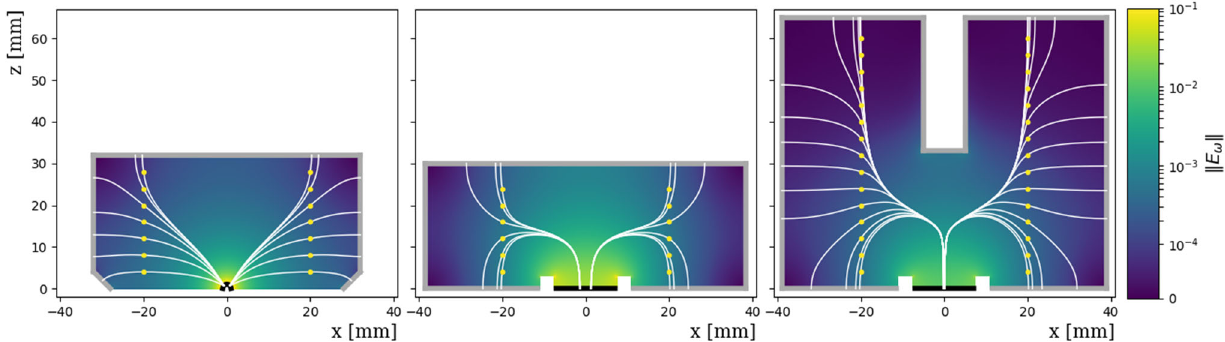
deposition, the white trajectories connecting them to the p + electrode arethedriftpathsofholesandthoseconnectingthemtothen + electrode are the drift paths of